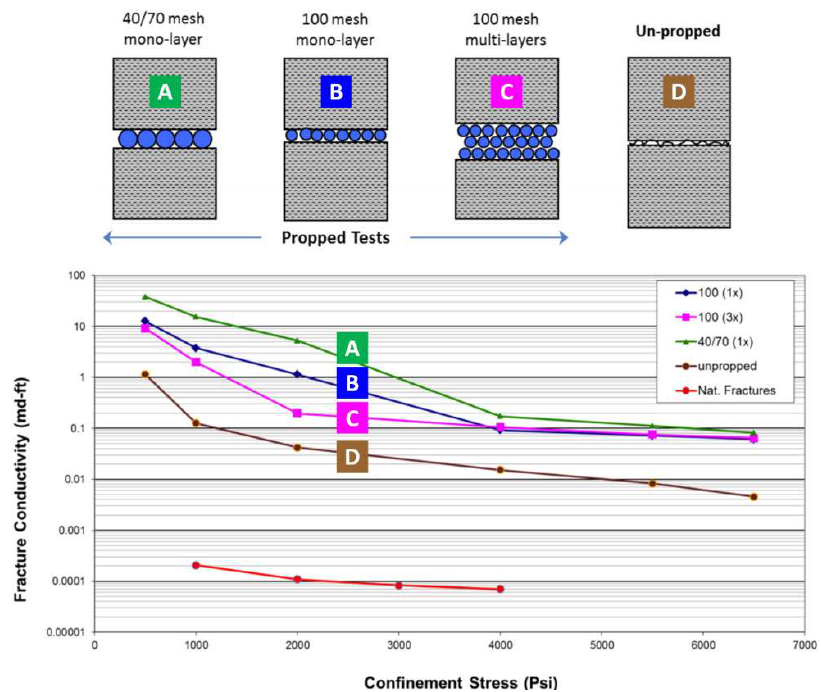
Figure 13. Fracture conductivity measurement test results that show fracture conductivity reduction by confining stress increase [48]. Reproduced from [48], Kam: 2014.